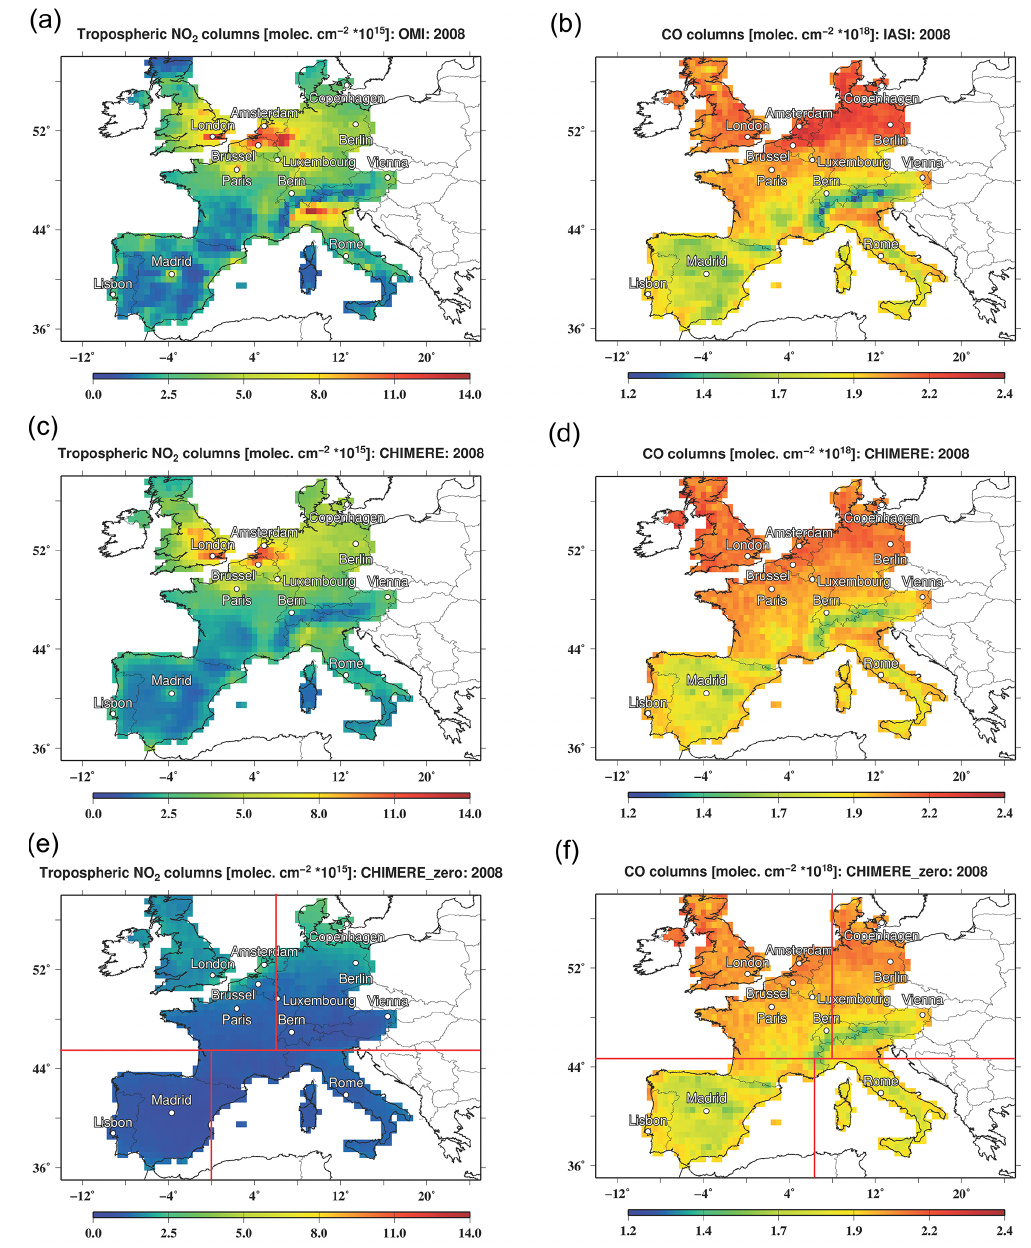
Figure 4. Spatial distributions of the annually averaged NO 2 (a, c, e) and CO (b, d, f) columns obtained from satellite observations (a, b) and model runs performed with (c, d) and without (e, f) anthropogenic emissions in the study region. Red lines (e, f) depict four subregions used in the uncertainty analysis described in Sect. 3.4; the subregions contain approximately the same amounts of daily data. Note that the simulation data have been debiased (in the same way as the data shown in Fig. 3a, b). Note also that the data which are not taken into account in our inverse modeling analysis are not